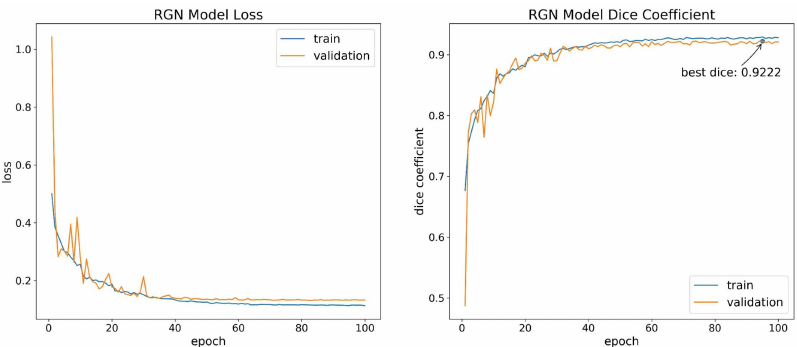
Figure 5. Loss and dice curves of the RGB image dataset model.